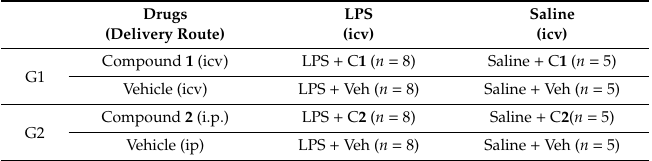
Experimental groups 1 (G1) and 2 (G2): LPS (lipopolysaccharide) was delivered intracerebroventricularly (i.c.v.) using stereotaxic coordinates, 10 ug total was injected, unless